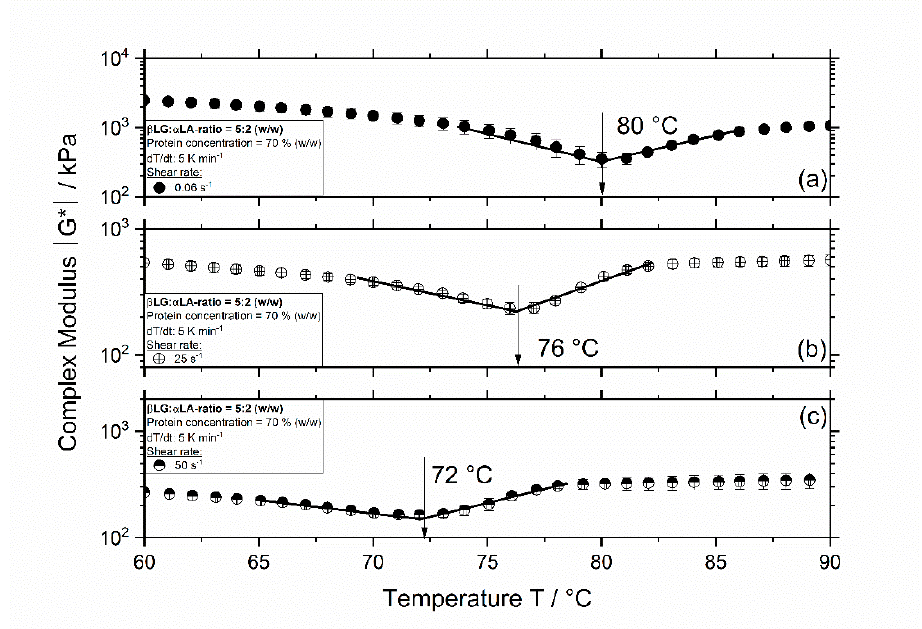
Figure 1. Complex modulus | G ∗ | as a function of temperature for 5:2 systems with a concentration of 70 % ( w/w ) and a shear rate of 0.06 s − 1 ( a ), 25 s − 1 ( b ), and 50 s − 1 ( c ). Measurements were performed at a constant heating rate of 5 K min − 1 , bars represent standard deviation (SD).